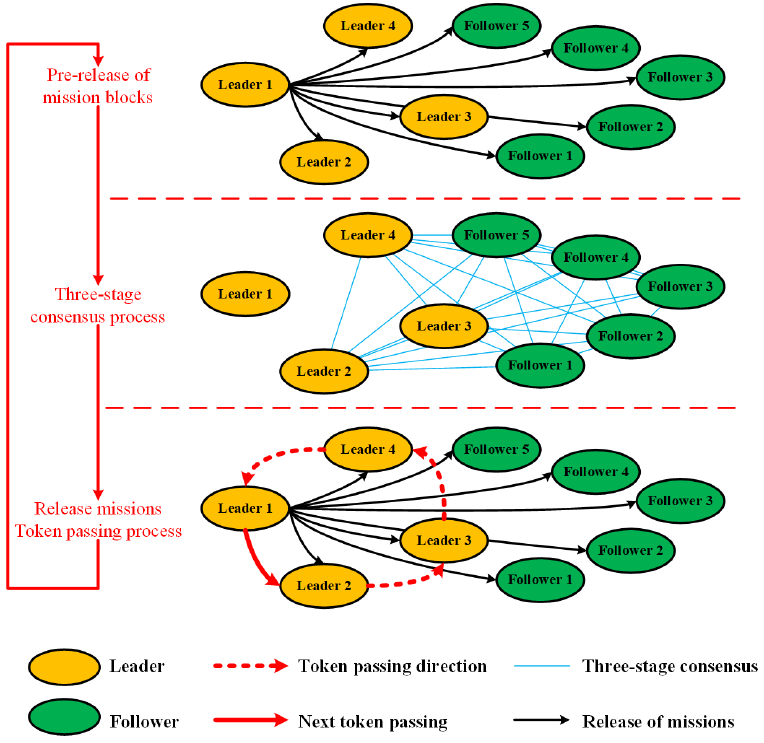
Figure 5. Algorithm flowchart of RIPPLE.